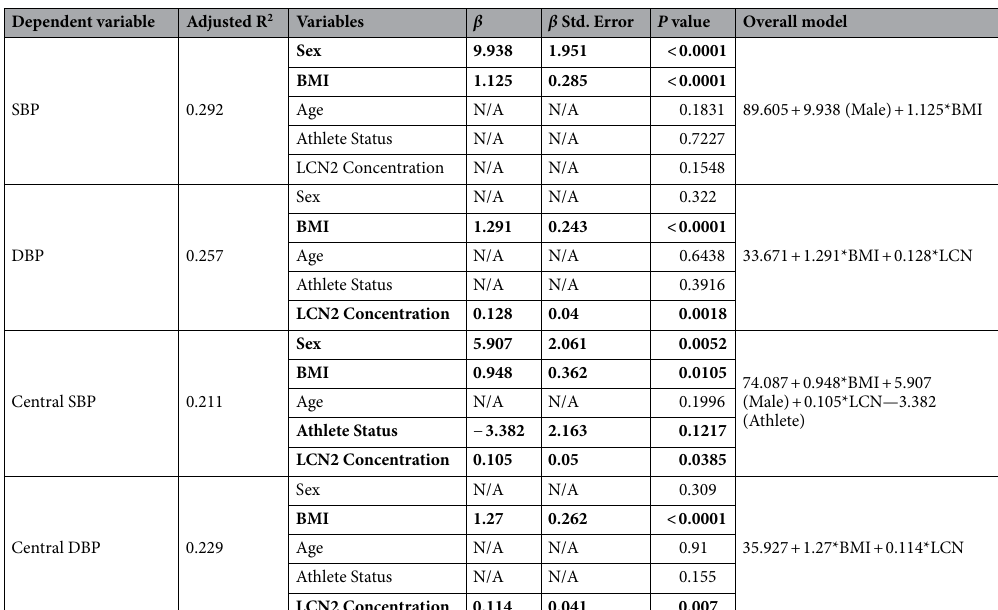
Table 6. Sensitivity analysis performed on blood pressure testing cohort demographic characteristics and LCN2 concentration. Significant contributors to the model are bolded, with their specific contributions shown in the overall model column. BMI, body mass index; SBP, systolic blood pressure; DBP, diastolic blood pressure; LCN2, lipocalin-2.